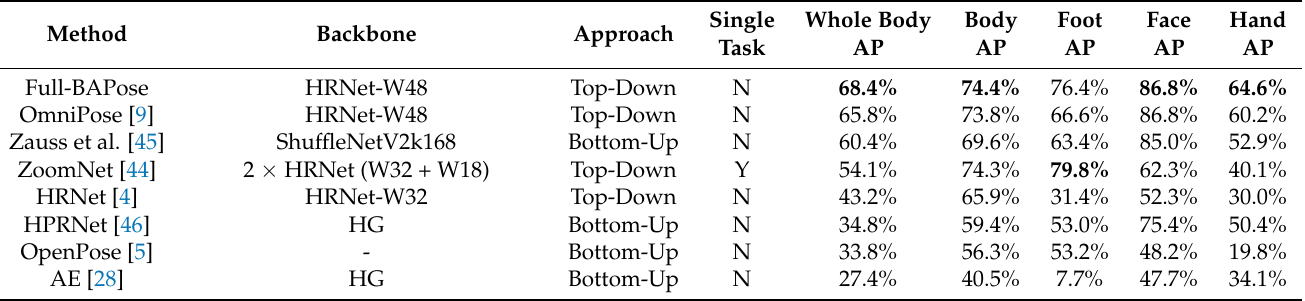
Table 5. Full-BAPose results and comparison with SOTA methods for the COCO-WholeBody dataset for validation. Best results are in